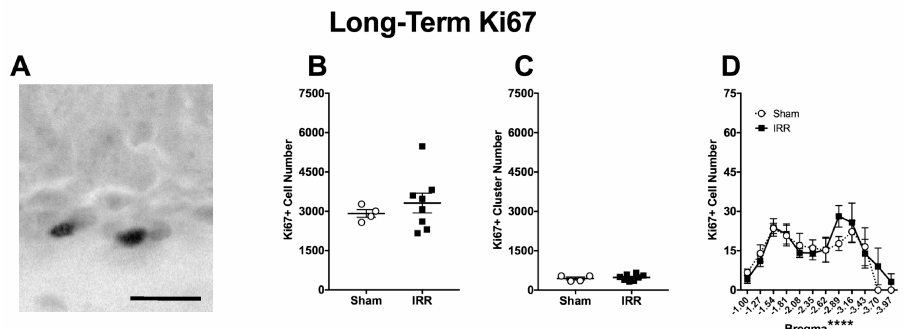
Figure 6. Three-mon post- 12 C irradiation, there was no difference in the number of Ki67+ cells or clusters between IRR and Sham mice. ( A ) Representative photomicrograph of Ki67 staining in a Long-Term Sham mouse (mouse #13850; 400 × , scale bar = 25 µ m). ( B ) An unpaired t -test revealed no difference in the number of Ki67+ cells in the SGZ ( p > 0.05; N = 4 Sham, N = 8 IRR). ( C ) An unpaired t -test revealed no difference in the number of Ki67+ clusters in the SGZ ( p > 0.05). ( D ) Bregma analysis of Ki67+ cells in the SGZ through two-way ANOVA (Bregma × Treatment) revealed a main effect of Bregma ( F 11,110 = 5.509; **** p < 0.0001), but not of Treatment ( F 1,10 = 0.2151; p > 0.05) and no significant interaction ( F 11,110 = 0.4856; p > 0.05). Post-hoc (Sidak’s multiple comparison) test revealed no significance at any single bregma. Error bars ±